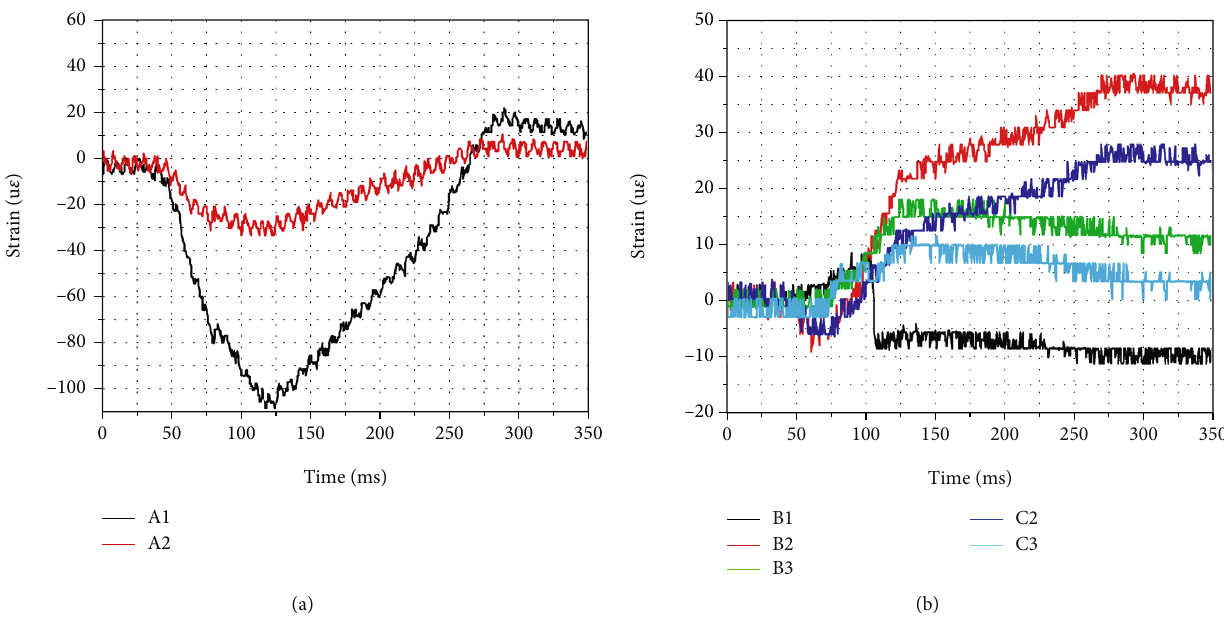
Figure 14: Monitored strain during fi rst shock: (a) vertical grating string; (b) transverse grating